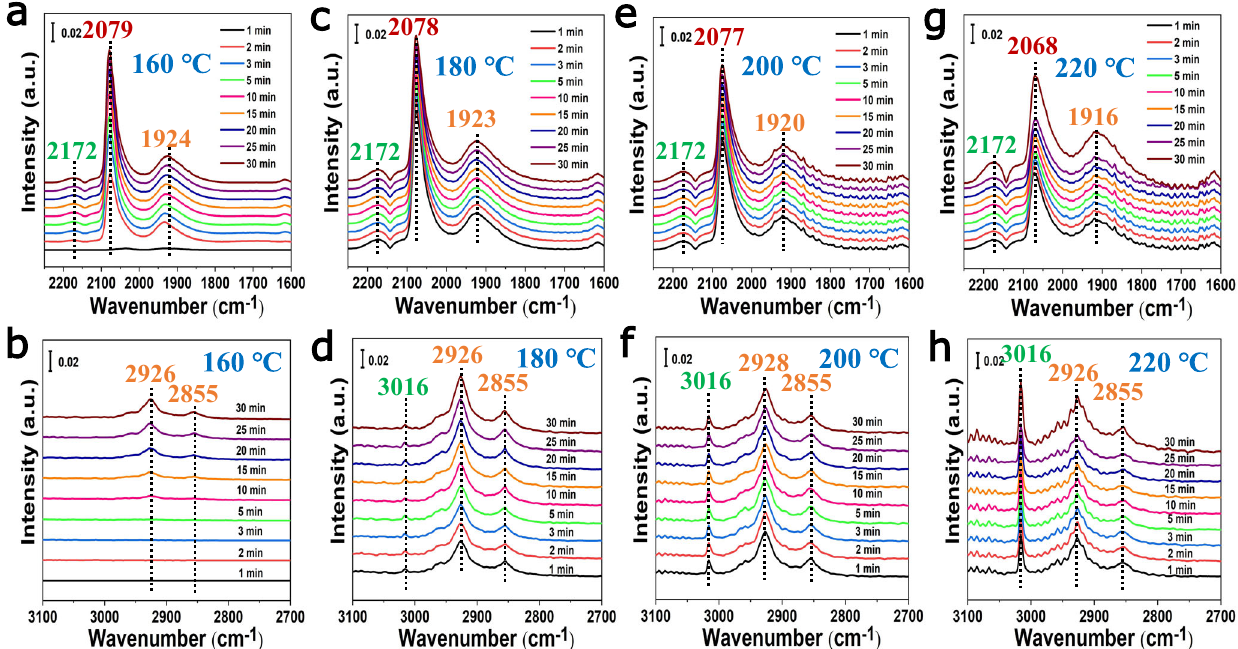
Fig. 4 | The investigation of CO hydrogenation mechanism via in situ IR spec- troscopy. Insitutime-resolvedDRIFTSspectrawerecarriedoutovertheTiO 2 − x /Ni- 450 catalyst at a , b 160°C, c , d 180°C, e , f 200°C, g , h 220°C, respectively. The corresponding spectrawererecordedin 2250 − 1600cm − 1 and 3100 − 2700cm − 1 at